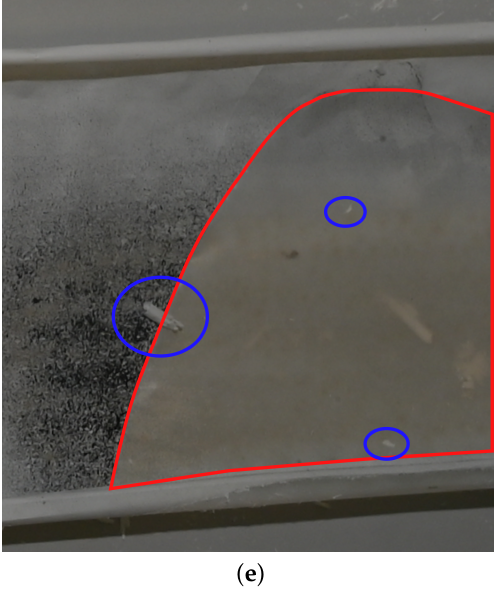
Figure 4. Pictures of a separator part of the aged type 1 cell with the area of delaminated coating inside the red lines and agglomerates of delaminated ceramic in blue circles ( e ) and the fully-discharged anodes from fresh and aged cells. ( a ) Fresh type 1 cell; ( b ) aged type 1 cell; ( c ) fresh type 2 cell; ( d ) aged type 2 cell.